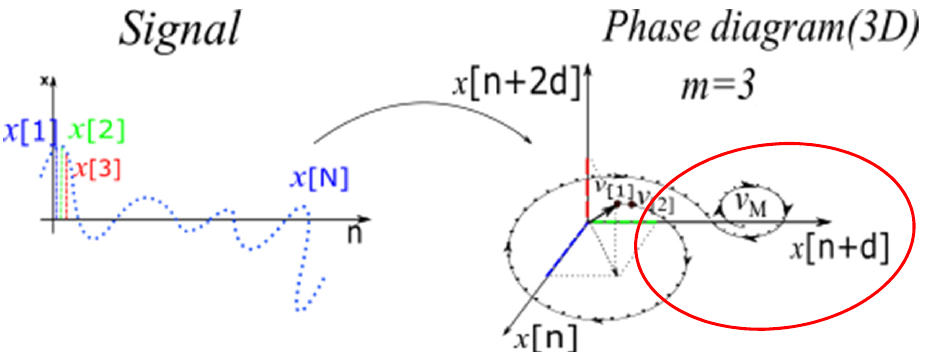
Figure 2. Inscription of the phase diagram representation in an ellipse (red) that defines the threshold σ .